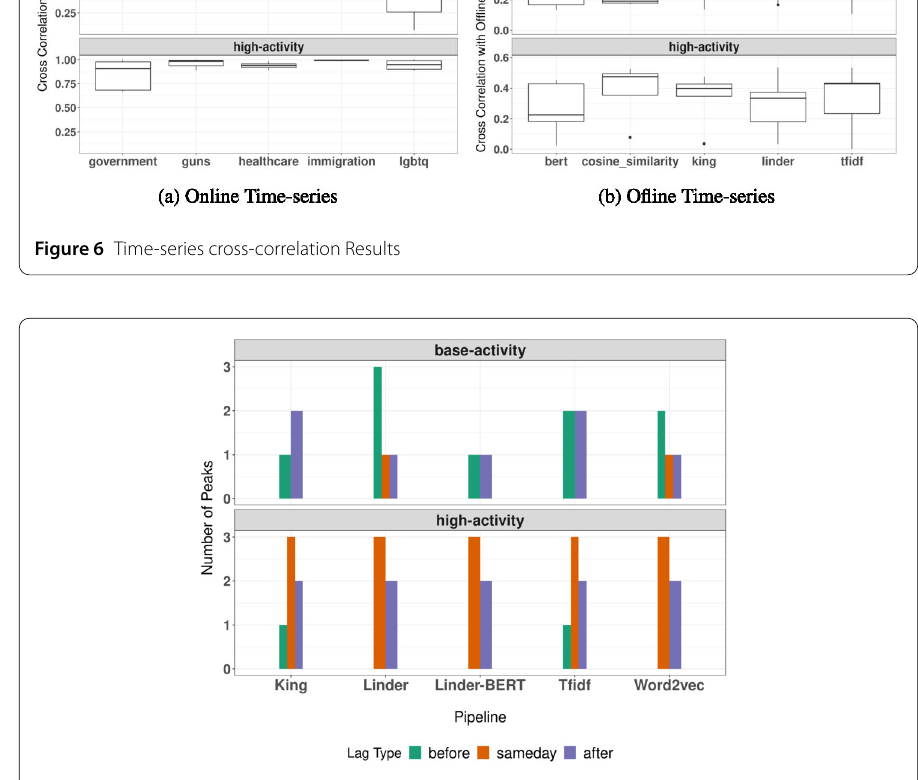
Figure 7 The x -axis indicates the pipelines, and the y -axis is the number of matched bursts with lag type (e.g., green indicates that an online burst took place before an offline